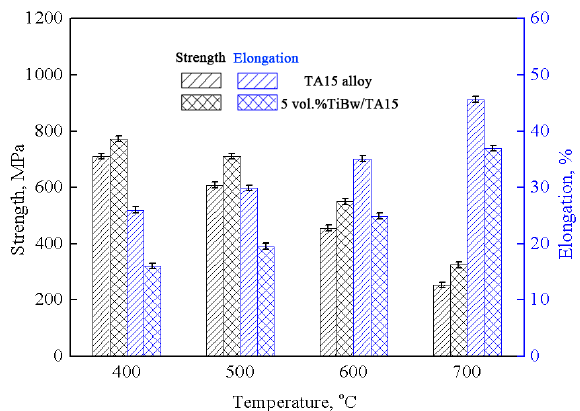
Figure 8. High-temperature tensile properties of the as-sintered monolithic TA15 alloy and 5 vol % TiBw/TA15 composites at 400 °C, 500 °C, 600 °C, and 700 °C.